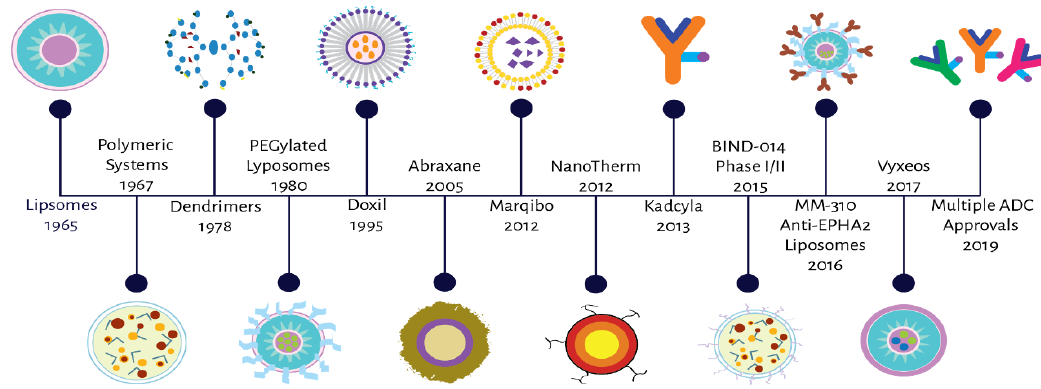
Figure 1. A brief history of the development of nanomedicines and other carrier-mediated agents. Table 1. Summary of FDA-approved carrier-mediated agents (including nanomedicines) with oncology indications for therapeutic